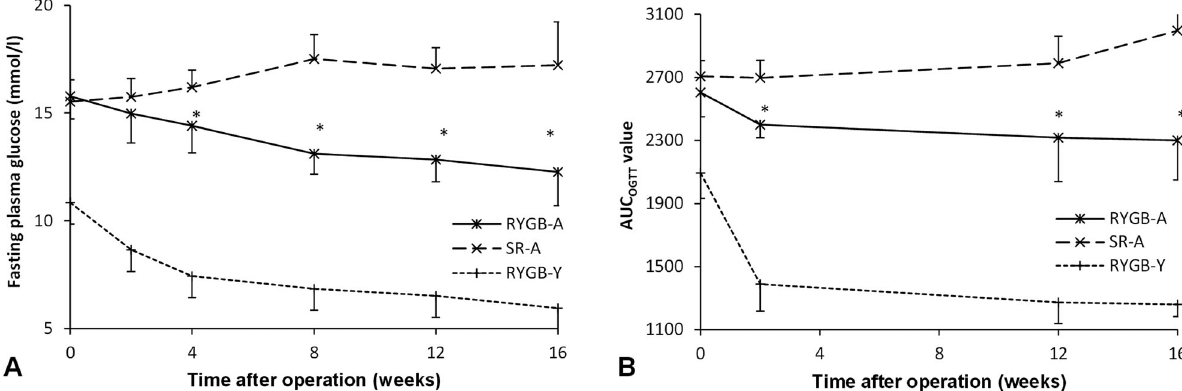
Fig. 3 The effect of RYGB on the improvement of blood glucose. A The fasting glucose curve of three groups. RYGB-A rats showed a lower fasting glucose level compared to the SR-A group after surgery. B The AUC OGTT during the postoperative period. Rats of the RYGB-A group showed amelioration of diabetes after surgery, and their AUC OGTT value was less than that of the SR-A group. The asterisk means signi fi cantly different compared to the SR-A group ( P < 0.05). AUC, areas under curve. RYGB-A, aged rat with Roux-en-Y gastric bypass. SR-A, aged rat with sham Roux-en-Y gastric bypass. RYGB-Y, young rat with Roux-en-Y gastric bypass. OGTT, oral glucose tolerance